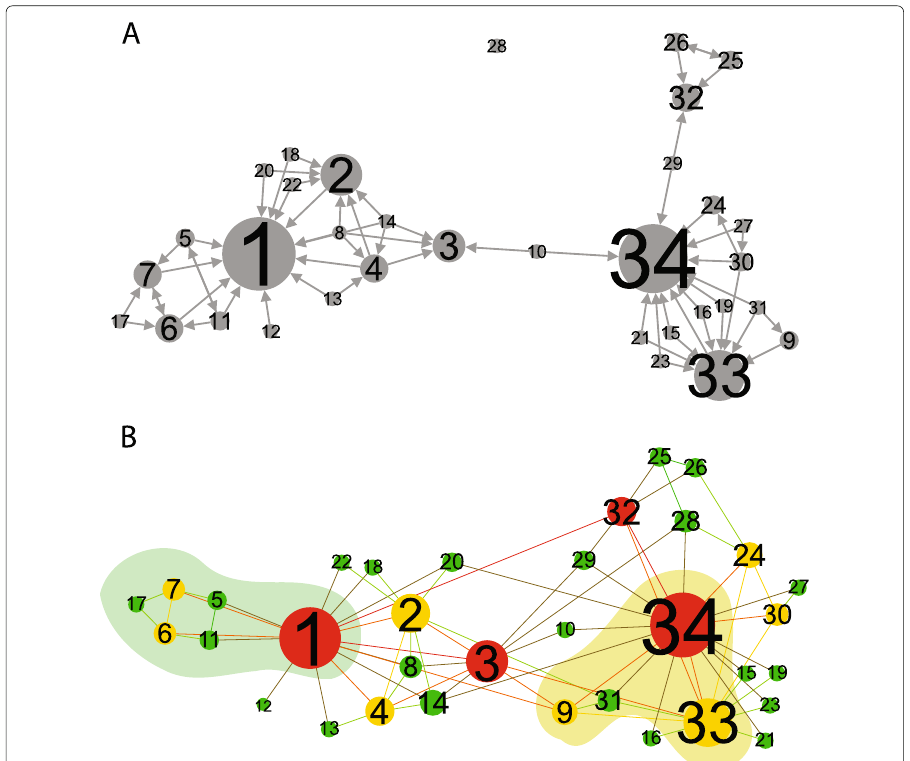
Fig. 2 Karate Club. Transformed unweighted directed network ( a ), and network with strongly-prominent nodes marked in red and weakly-prominent nodes in yellow ( b ). For the isolated node 28 in sub-figure a it is true that it is not dependent on any other node and at the same time, no other node in the network is dependent on it. Node 10 is dependent on nodes 3 and 34. Most nodes are dependent on nodes 1 or 34. There are nodes 32,6,7,14,28 with different prominency (see Definition 5), but a comparable degree. Node 32 is strongly-prominent ( OwIndep = 3, TwDep = 0, OwDep = 0, Prominency = 1, Degree = 6). Nodes 6 and 7 are weakly-prominent ( OwIndep = 2, TwDep = 1, OwDep = 1, Prominency = 0.667, Degree = 4) because of their dependency on each other and on node 1. Nodes 14 or 28 are non-prominent ( OwIndep = 0, TwDep = 0, OwDep = 4 or 0, resp., Prominency = 0, Degree = 5 or 4, resp.) because no other nodes are dependent on them. As explained in Fig. 7 in “Ego-zones” section, sub-figure b displays one multi-ego zone (green) with egos 6 and 7, and one group of nodes (yellow) representing two alternative zones with egos 9 or 31,